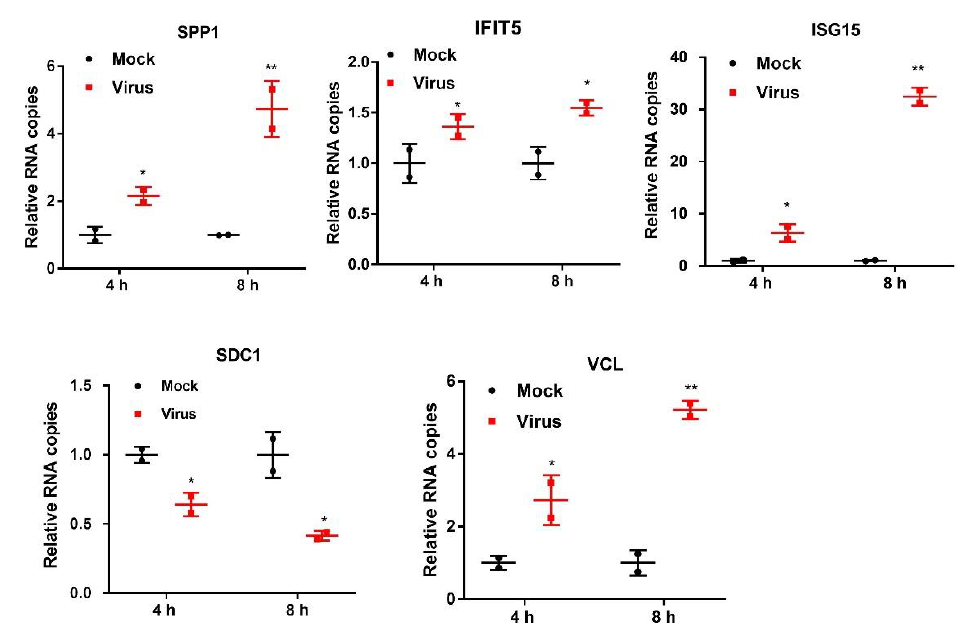
Figure 7. The expression of the indicated genes and kinetics in PK-15 cells infected with PSV for 4 h and 8 h was measured by RT-qPCR. Data are shown as mean ± SD for two experiments; * p < 0.05, ** p < 0.01.